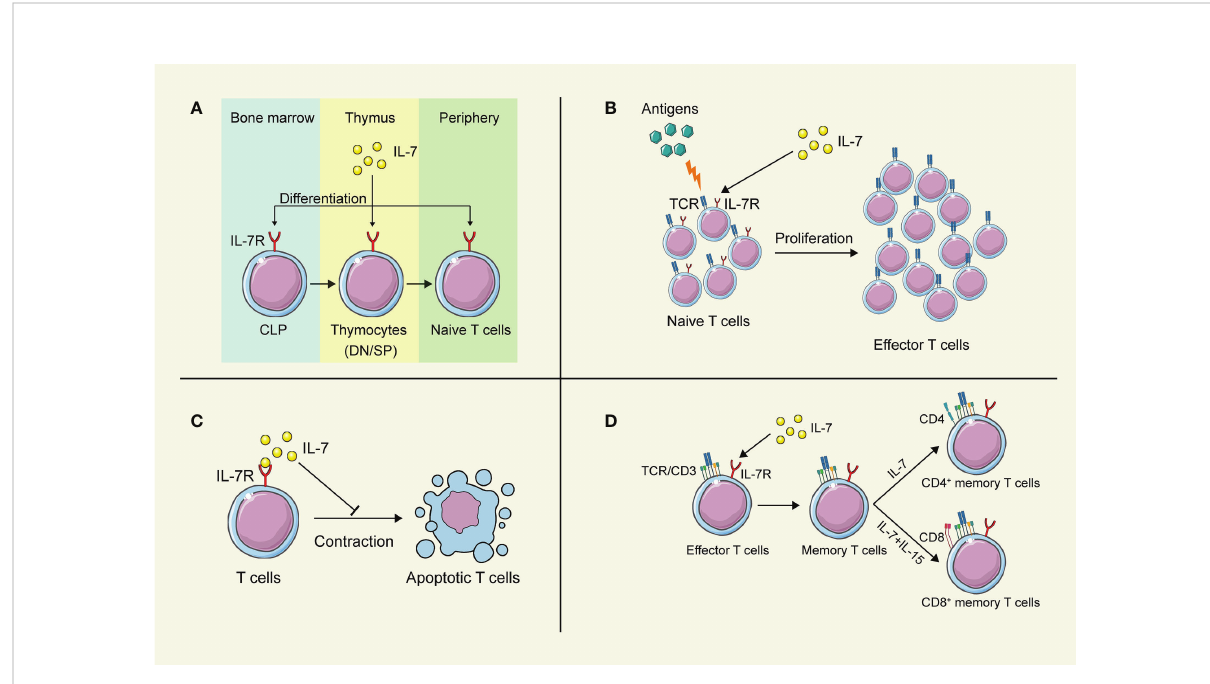
FIGURE 2 The biological function of IL-7 on T lymphocytes. (A) IL-7 contributes to the development of T cells in the thymus. (B) IL-7 boosts the proliferation of T cells after stimulation by antigens. (C) IL-7 prolongs the survival of T cells. (D) IL-7 promotes the differentiation of memory T cells. This fi gure is created with BioRender.com and